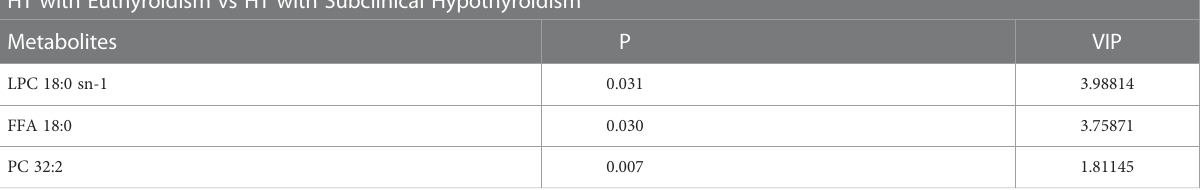
TABLE 4.2 The identi fi cation metabolites of HTE vs HTS group. HT with Euthyroidism vs HT with Subclinical